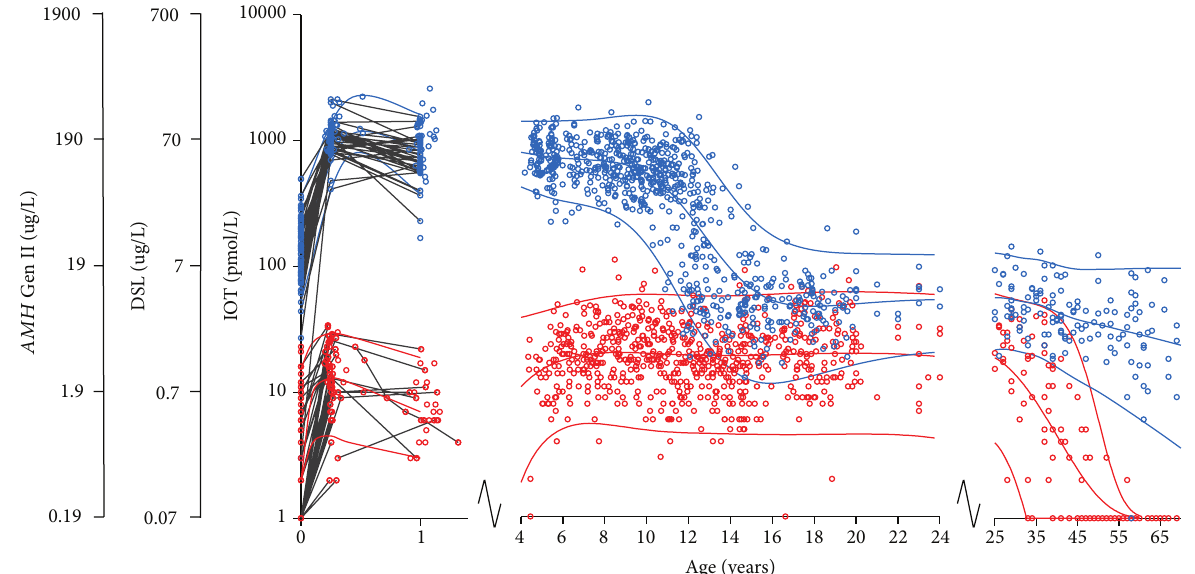
Figure 2: Serum AMH in 1953 healthy subjects (926 females and 1027 males) according to age. Females: red circles, males: blue circles. Longitudinal values during infancy are connected with grey lines. The red and blue curves represent the female and male reference ranges, respectively (median, ± 2SD). The figure was redrawn from our previously published data using Immunotech Coulter enzyme immunometric assay in all subjects [11–13]. Please note the logarithmic 𝑦 -axis. The 𝑦 -axes for the DSL and Gen II assays were created using the following